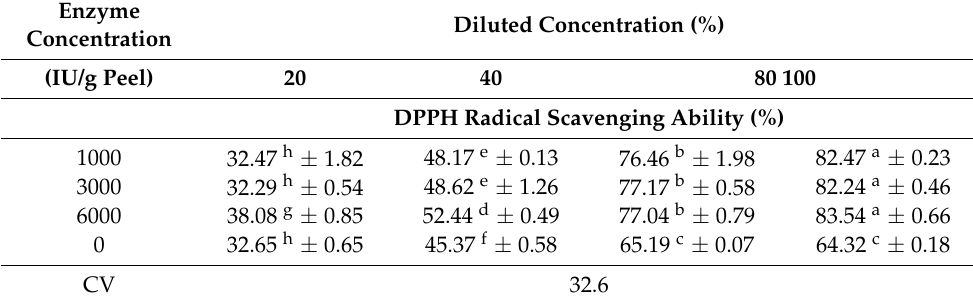
Table 6. DPPH free radical scavenging activity of pomelo peel.